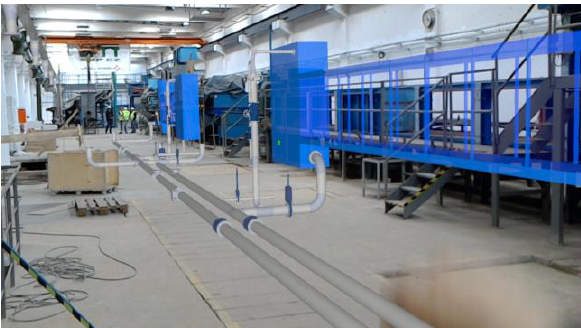
Figure 5. Mixed reality in Microsoft